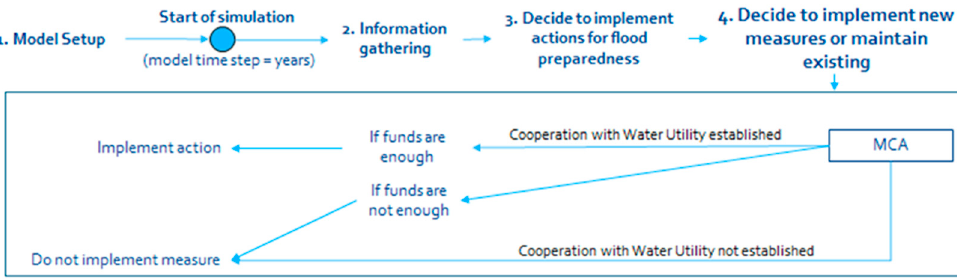
Figure 5. Procedure for implementing actions for flood preparedness.